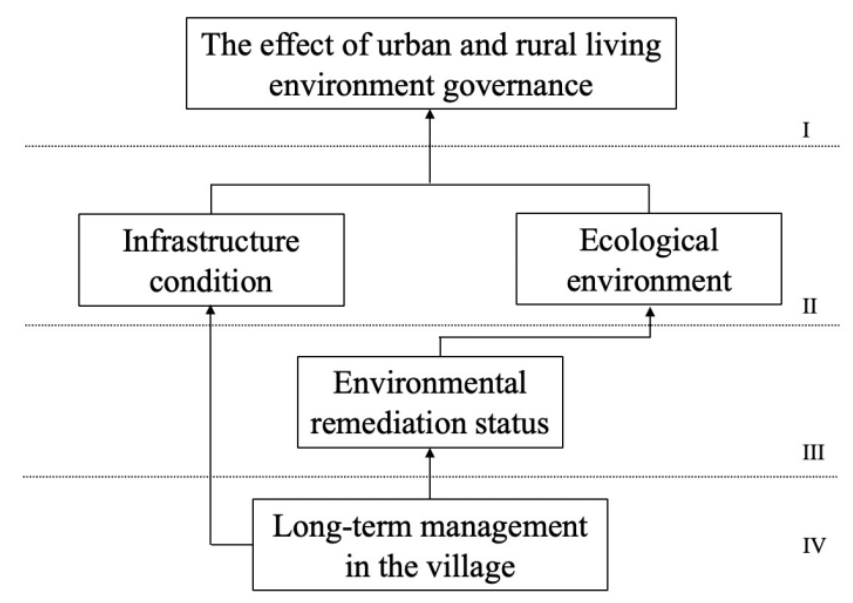
Figure 4. Interpretation of structural model diagram.